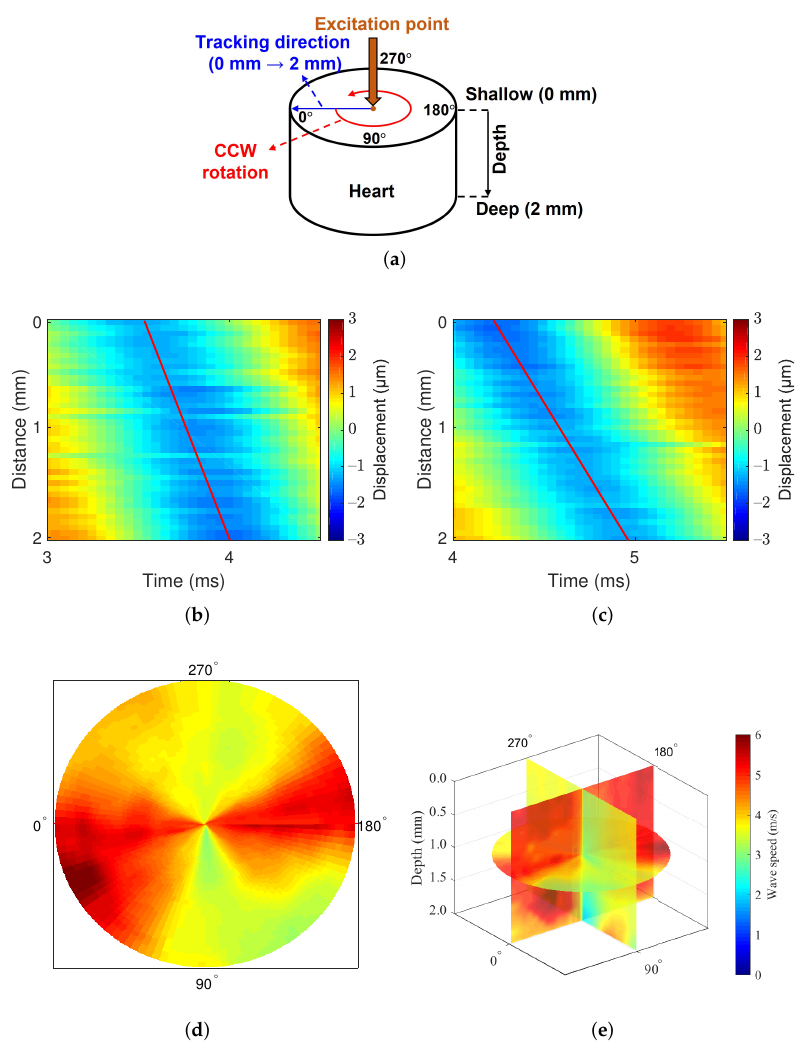
Figure 6. Heart image: directional dependence of the heart at the middle myocardium. The slope of the red line indicates the wave speed. ( a ) Data acquisition, ( b ) displacement map: circumferential direction, ( c ) displacement map: longitudinal direction, ( d ) heart image: 0 mm depth, and ( e ) heart image: 360 ◦ (A depth of 0 mm does not mean the surface, but the point at which the ultrasound transducer started measuring inside of the